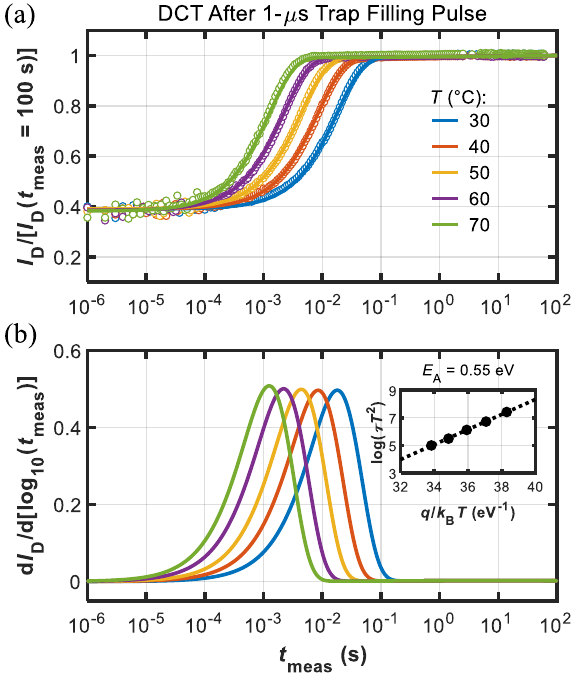
Figure 5. ( a ) DCTs measured at different temperature (see legend) after the short 1 us trap-filling pulse (dots are data and lines are fitting functions). Current was normalized to final value, i.e., I D ( t meas = 100 s). ( b ) d I D /d[log10( t meas )] used for the extraction of the time constants ( τ ) to build the Arrhenius plot (see inset) that yielded E A = 0.55 eV.